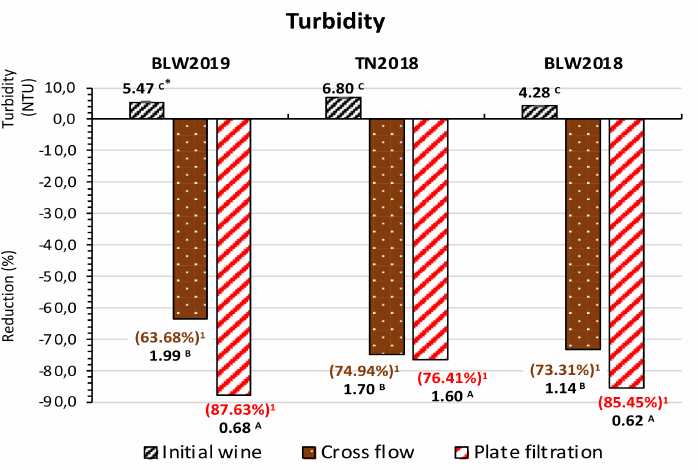
Figure 1. The impact of the two different filtration techniques on the turbidity variation values for the three red wines studied. NTU, nephelometric turbidity units; TN2018, the red wine produced from the Touriga Nacional grape variety in 2018; BLW2018, the red wine produced from a blend containing Touriga Nacional, Tinta Roriz, Alfrocheiro and Jaen grape varieties in 2018; BLW2019, the red wine produced from a blend containing Baga and Tinta Pinheira grape varieties in 2019. 1 The percentage of reduction in relation to the unfiltered wine. * The average values with the same letter and for the same red wine are not significantly different (Tukey test, p <